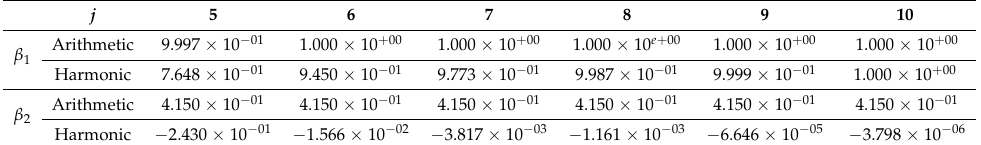
Table 1. Numerical estimation of the limit functions regularity C 1 + β 1 − and C 2 + β 2 − for S NL in (3) and (4) using the arithmetic mean and the harmonic mean. The number of subdivision scales is represented by j